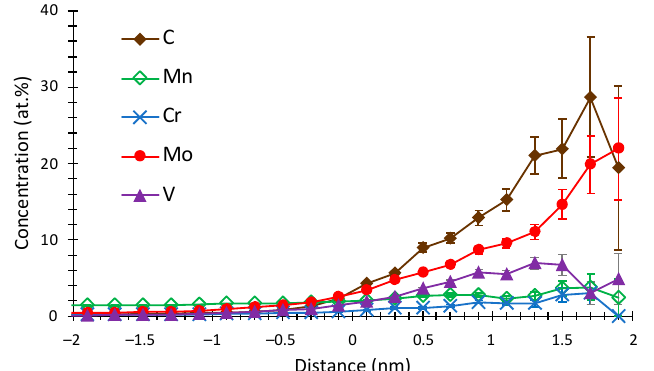
Figure 6. Proxigrams from the small carbides located on dislocations in Figure 5 from the sample aged 4 h at 600 °C.